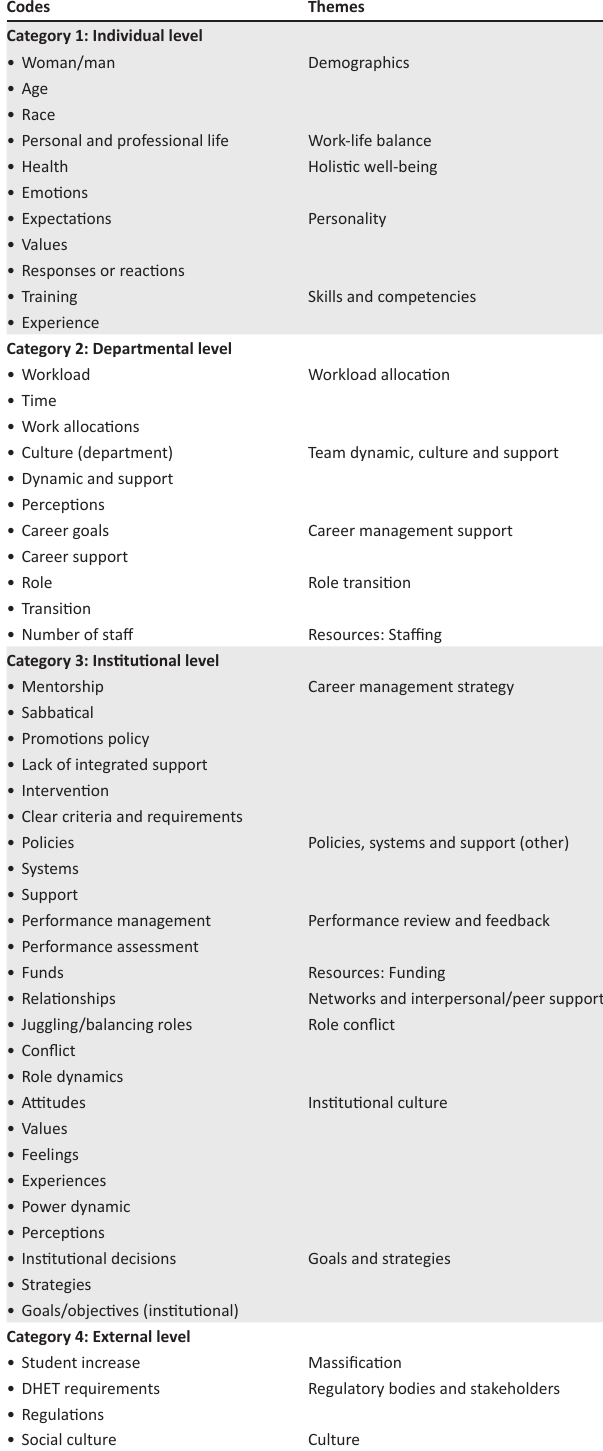
TABLE 2: Codes adopted to inform the